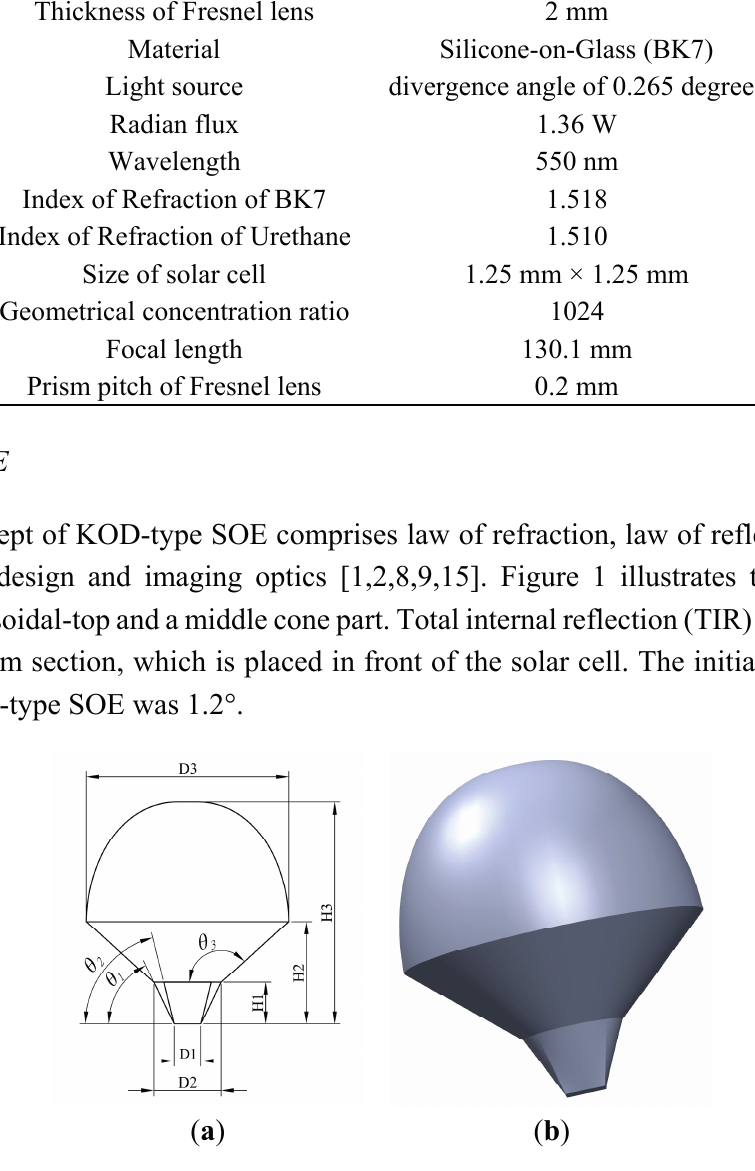
Figure 1. Illustration of KOD-type SOE ( a ) design parameters; ( b ) solid